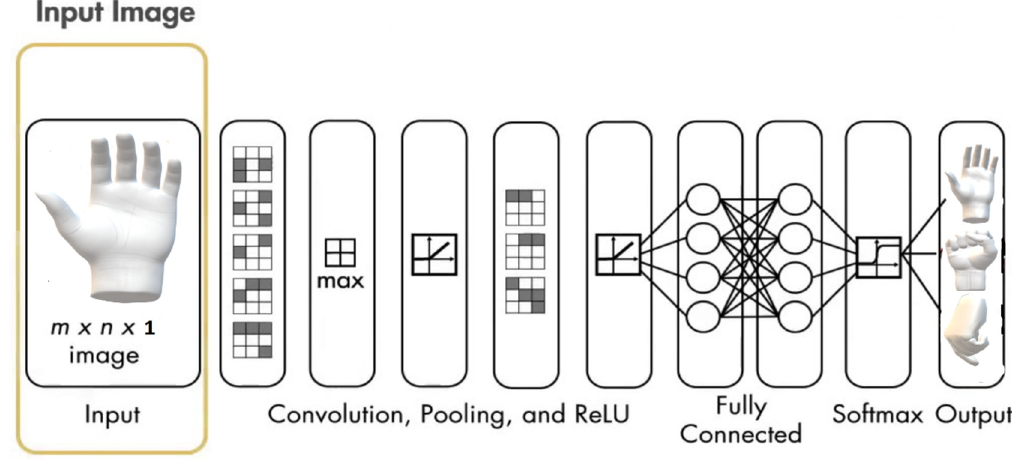
Figure 10. A CNN Concept.